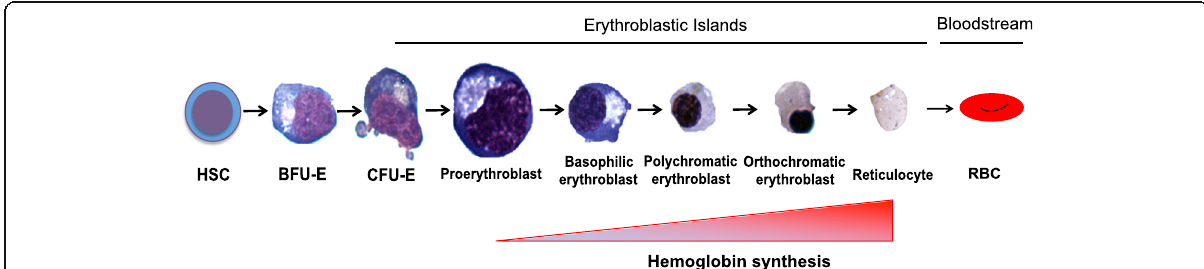
Fig. 1 Overview of erythropoiesis, from the hematopoietic stem cell (HSC) to the red blood cell (RBC). Erythropoiesis takes place in the bone marrow, and erythroblastic islands are niches for erythropoiesis from the CFU-E to the reticulocyte state. Then the reticulocyte reaches the blood stream where it achieves its maturation by losing its internal organelles, remodeling its plasma membrane and finally becomes a